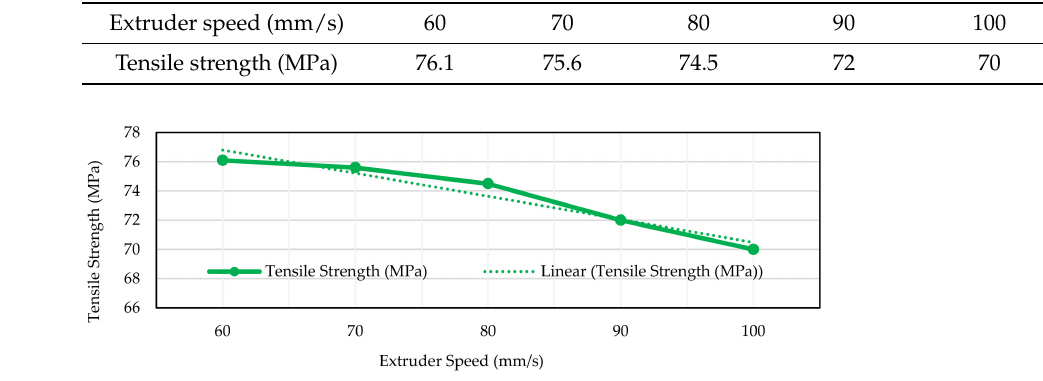
Figure 10. Tensile strength vs. extruder